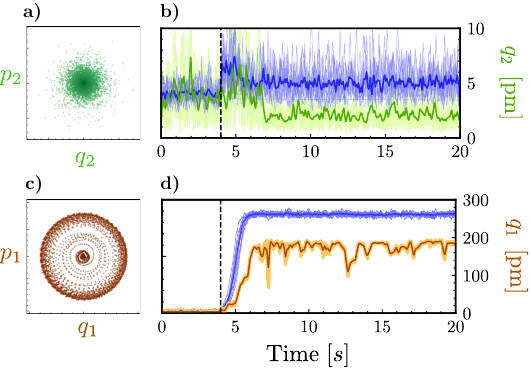
Figure 7. ( a , c ) Phase space distributions associated with the amplitude displacements of the two oscillators. ( b ) Observed displacement amplitudes, q 2 , as a function of time for the fundamental mode of the second resonator, and ( d ) for the first resonator, q 1 , which goes into a limit cycle. Green and orange curves indicate experimental data, and darker curves are a convolution over 200 points. The (cid:39) 2.1 pm, to be compared with the expected measured steady-state values are q 1 (cid:39) 184 pm, and q st 2 values 183.0 pm, and 2.0 pm, respectively. The dynamics described by the integral of Equation (37) [and Equation (38)] is represented by the 10 blue trajectories in panel ( c ). The horizontal dashed lines in panels ( b , d ), shows the expected values given by Equation (52),